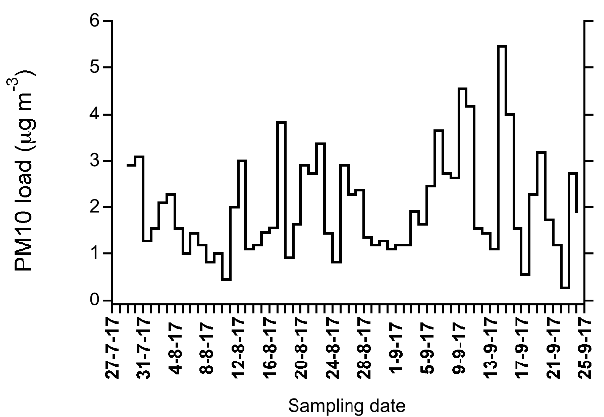
Figure 3. Daily mean concentrations of PM 10 concentration between 10 August and 15 September 2017 measured at the Gruvebadet station (Ny-Ålesund).